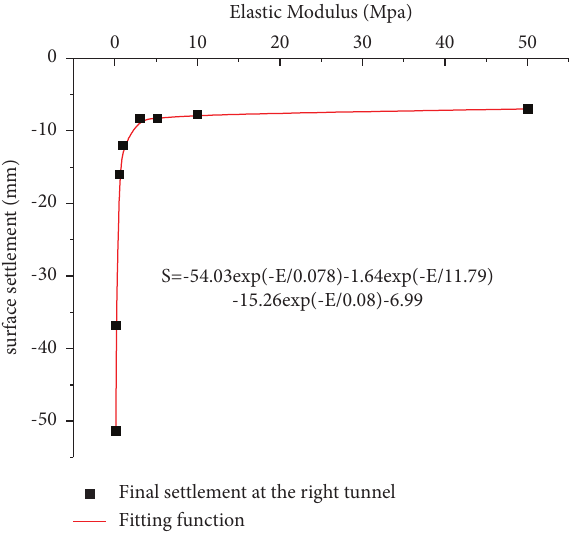
Figure 7: Excavation clearance fitting curve for the settlement obtained by numerical simulation.